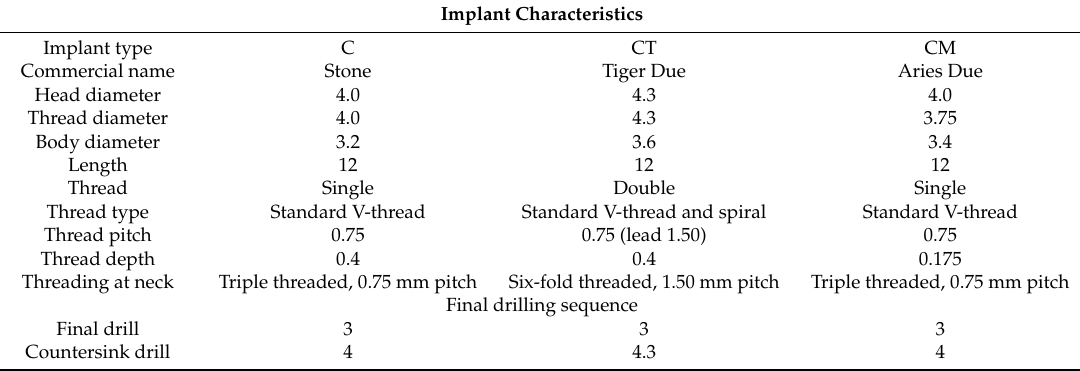
Figure 1. The three implants used in the present study. Their geometrical features are provided in Table 1. Left, the cylindrical Stone implant; center, the cylindrical-tapered Tiger Due implant; right, the modified cylindrical Aries Due implant. Table 1. Geometrical features of the implants used in the present study and corresponding final drilling sequence. C indicates cylindrical, CT cylindrical-tapered, and CM cylindrical-modified. All measures are given in mm.